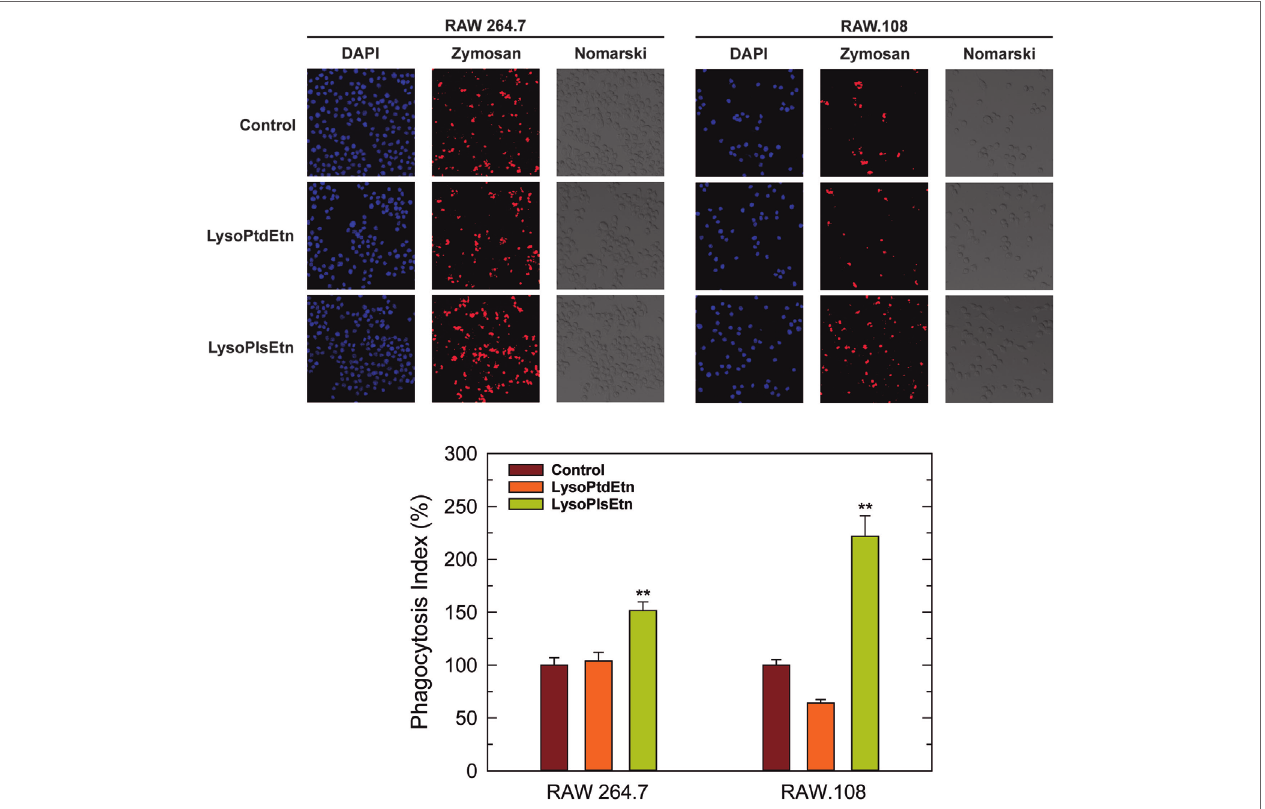
FigUre 4 | Effect of lysoPlsEtn on the phagocytosis of opsonized zymosan by RAW 264.7 and plasmalogen-deficient RAW.108 cells. The cells were either untreated (brown bars) or treated with 10 µM lysoPlsEtn (orange bars) or 10 µM lysoPtdEtn (yellow bars) for 10 min. Afterward, fluorescent zymosan particles (10 particles per cell) were added for 30 min, and phagocytosis was analyzed by confocal microscopy (red color, middle columns). DAPI (1 µg/ml) was used to mark the nuclei (blue; left columns). Nomarski images are also shown (right columns). The average of three independent experiments with 20 determinations each is shown in the bottom panel (mean ± SEM). Phagocytic indexes in the bottom panel are given as percent values with respect to controls without added lysophospholipids to allow for direct comparison between the responses of RAW 264.7 cells versus RAW.108 cells. Actual values were 112 ± 4 and 49 ± 2 for RAW 264.7 cells and RAW.108 cells, respectively. Original magnification, × 20. **Significantly different ( p < 0.01) from untreated